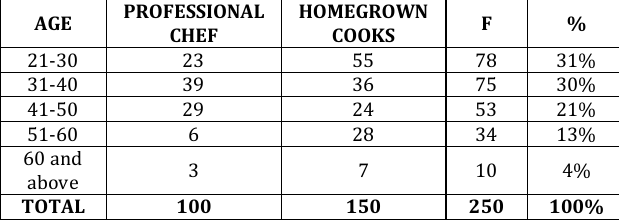
Profile of the Respondents AGE